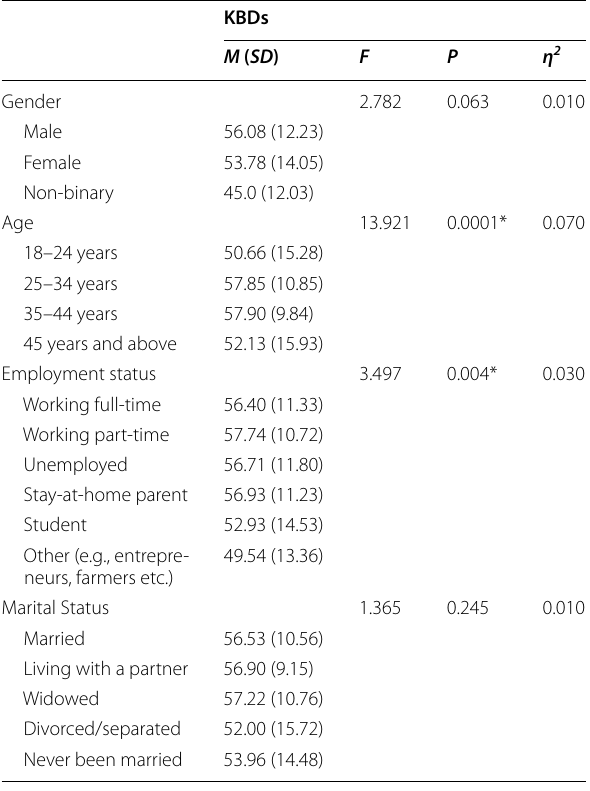
KBD knowledge of bipolar disorders, M mean, SD standard deviation * Indicates significant p value at <